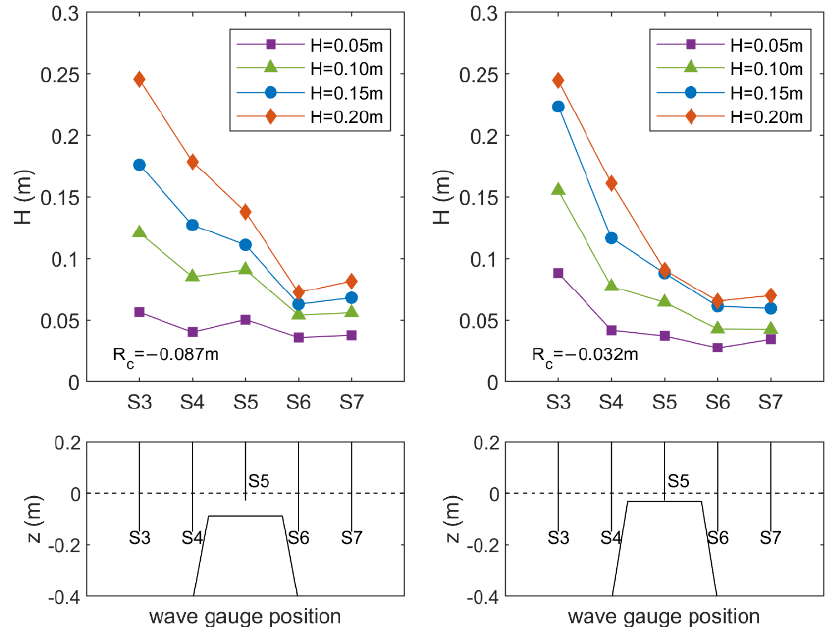
Figure 11. Wave height evolution before, over and behind a submerged breakwater with R c = − 0.087 m (left panel) and R c = − 0.032 m (right panel) for regular waves with different wave heights H = 0.05 m–0.20 m and a wave period T = 2.0 s.